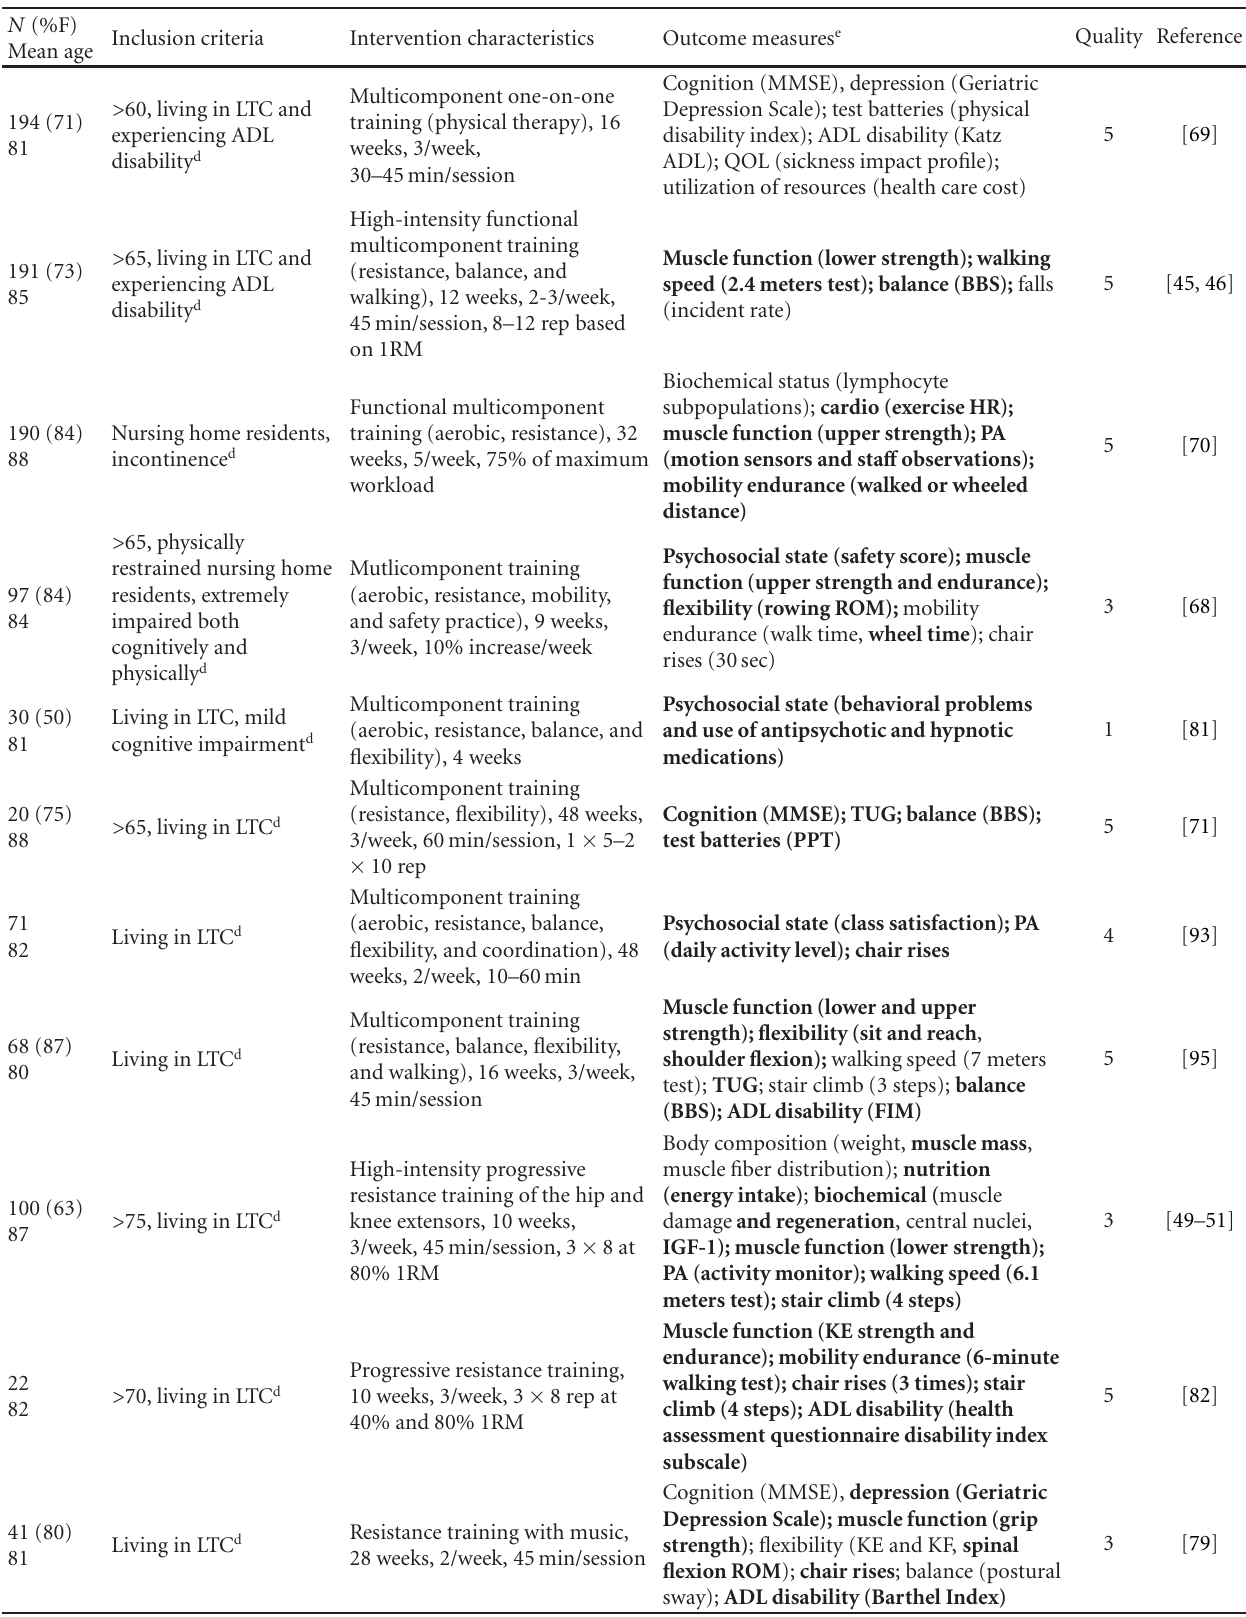
Table 1: Description of studies that were done in long-term